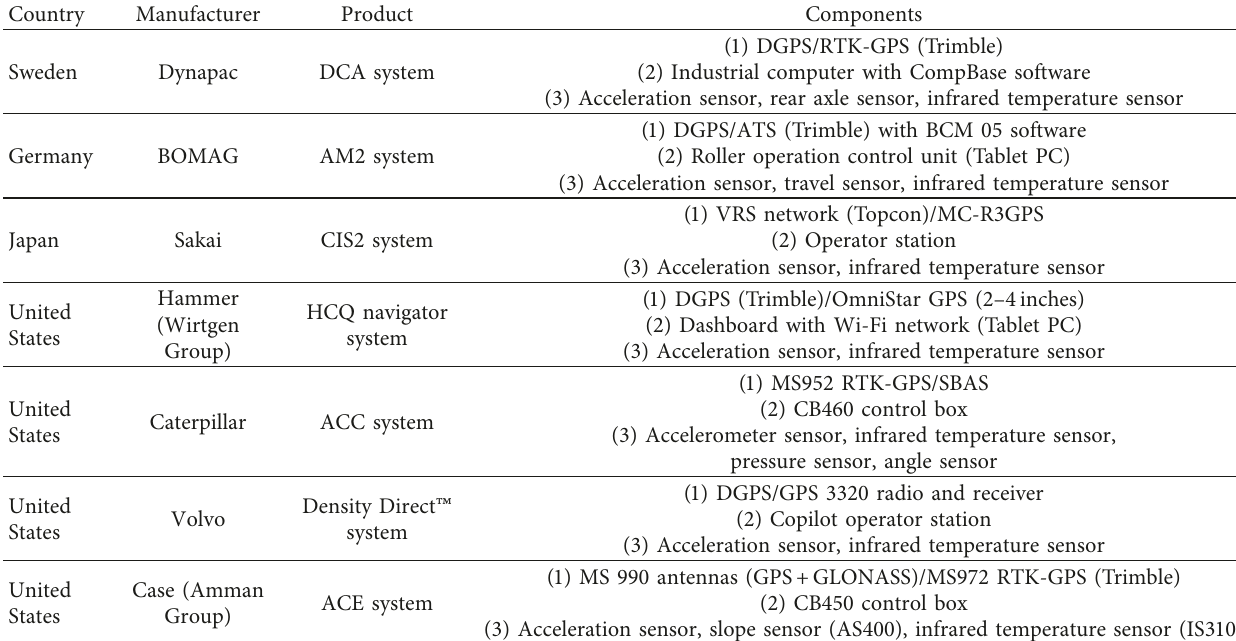
Table 1: Typical CCC system products.